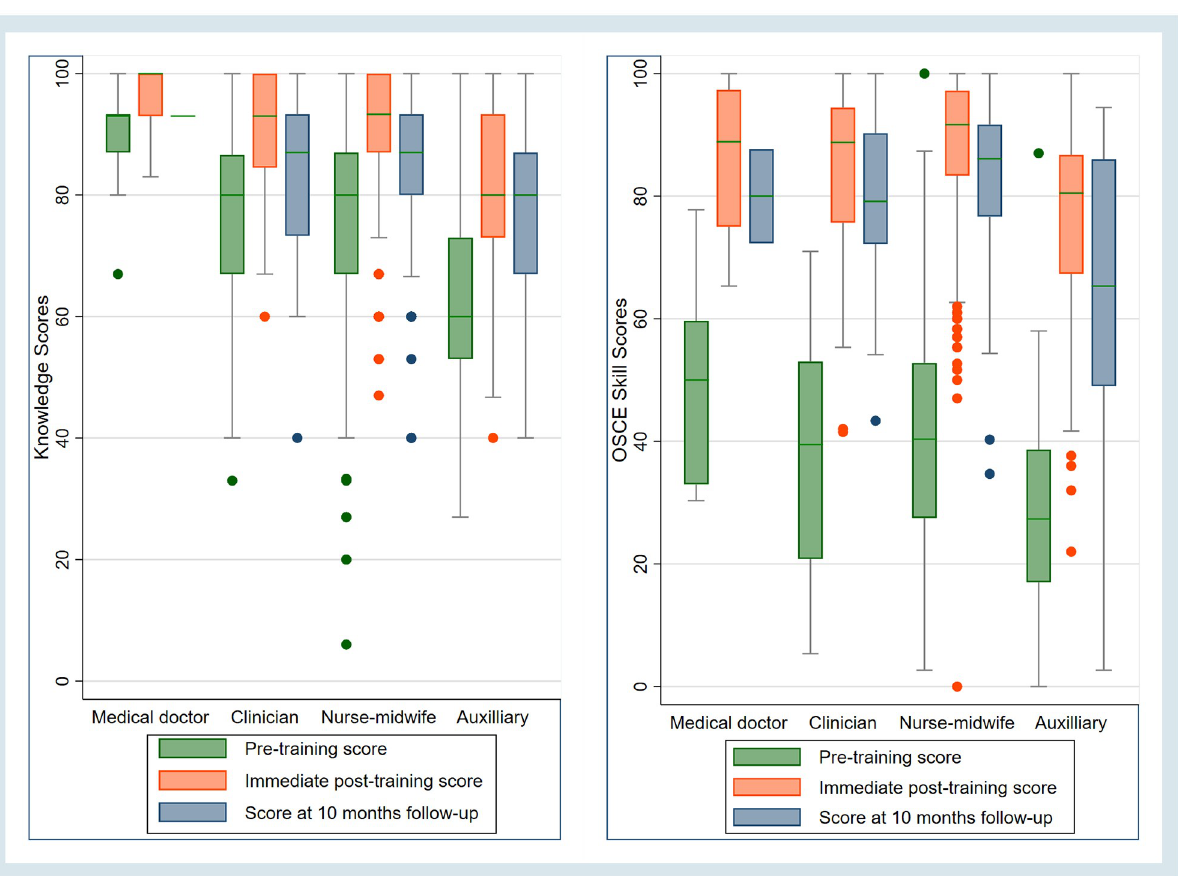
Fig 2. Box plot for knowledge (left) and OSCE skill score (right) on pre-training, immediately post training and 10-month follow-up for different health workers’ professions.